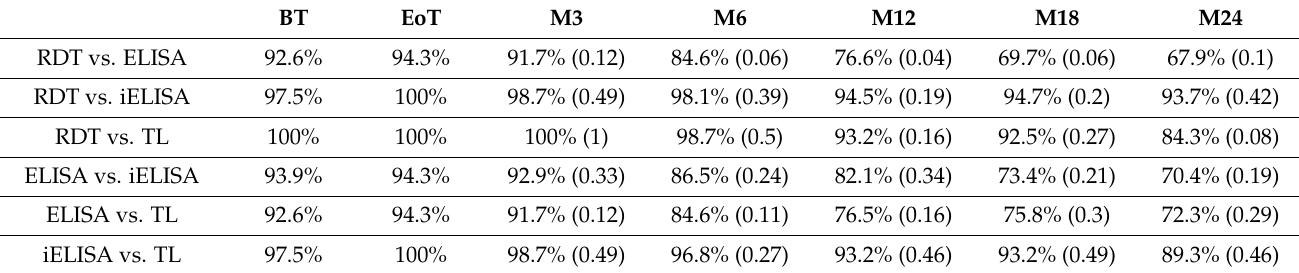
Table 4. Proportion of concordant results and agreement (Kappa) between tests at different time-